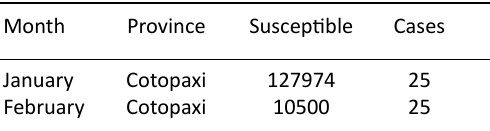
Table 2. Cases Susceptible to Avian Infectious